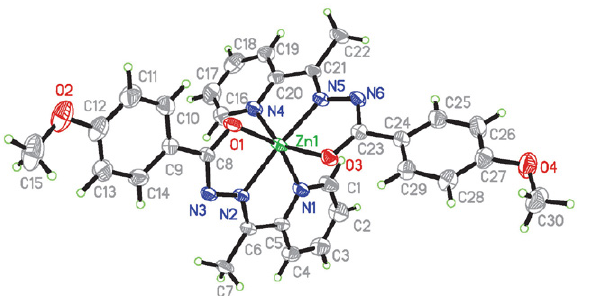
Figure 1. Molecular structures of complex 1 with ellipsoids at 30% probability.